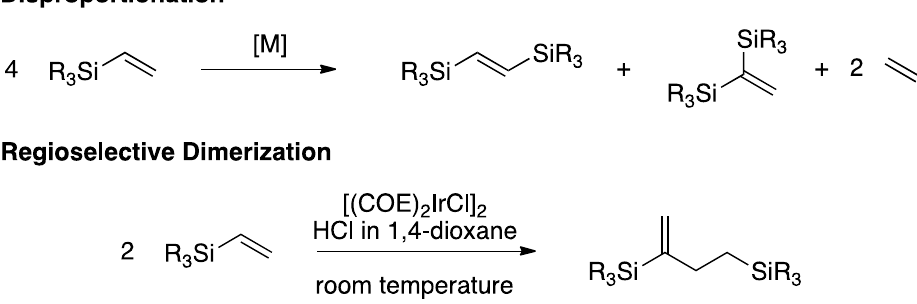
Scheme 1. Homocoupling of vinyl silanes via disproportionation or dimerization.